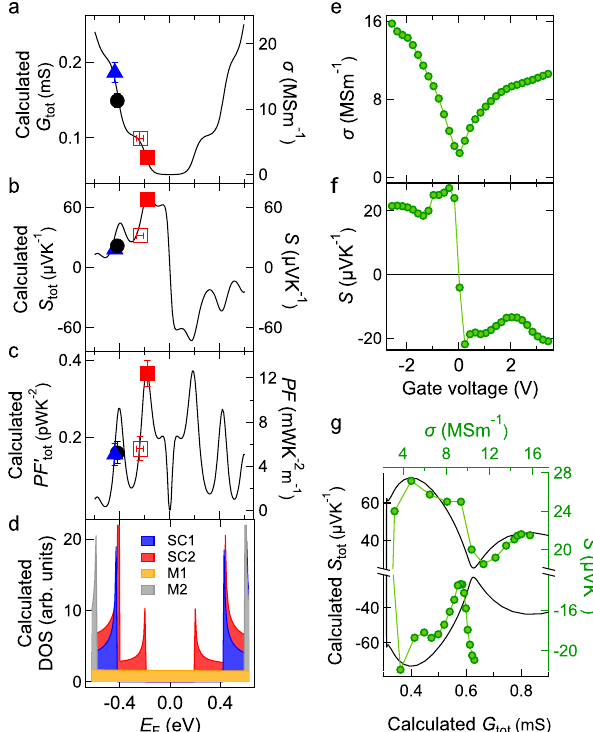
Fig. 2 Explaining the E F -dependent thermoelectric (TE) properties of carbon nanotube (CNT) fi bers through modeling. a Calculated electrical conductance G tot , b Seebeck coef fi cient S tot , and c power factor PF 0 G S 2 (left) versus Fermi energy E F . Experimental data from four tot tot chemically treated samples are shown by different symbols on the right axis as a function of the estimated Fermi energy: iodine monochloride (ICl) doped (solid blue triangle), as-produced (solid black circle), annealed at 350 °C (open red square), and annealed at 500 °C (solid red square). Error bars indicate SD. d The density of states (DOS) of four representative SWCNTs contained in our CNT fi bers, an inner-wall semiconducting SWCNT (SC1, blue), an inner-wall metallic SWCNT (M1, orange), an outer- wall semiconducting SWCNT (SC2, red), and an outer-wall metallic SWCNT (M2, gray). e , f TE properties tuned by the electrolyte gating technique. e , Measured electrical conductivity σ and f S as a function of gate voltage. g Comparison of calculated S tot (left) as a function of G tot (bottom) with experimental S (right) as a function of σ (top) with an offset in the x axis such that the examined range by the experiments agrees. The calculated S tot is plotted with a black line, and the experimental data for gated samples are shown by a green line with solid